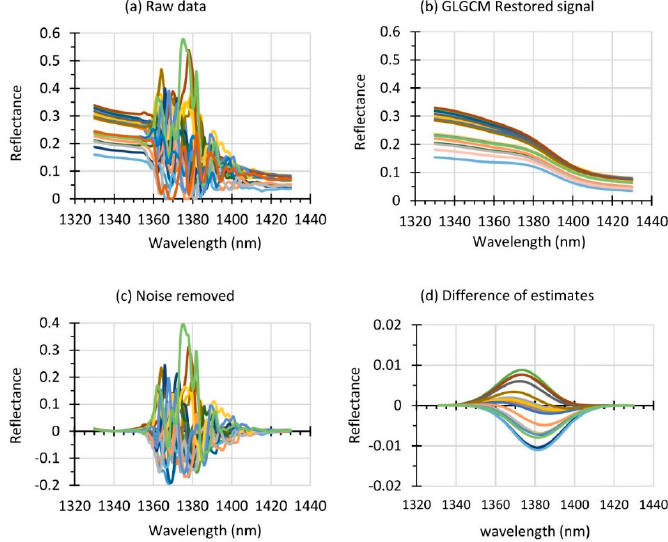
Figure 7. A validation of the SWIR signal restoration for the in situ forest canopy noisy spectral data.